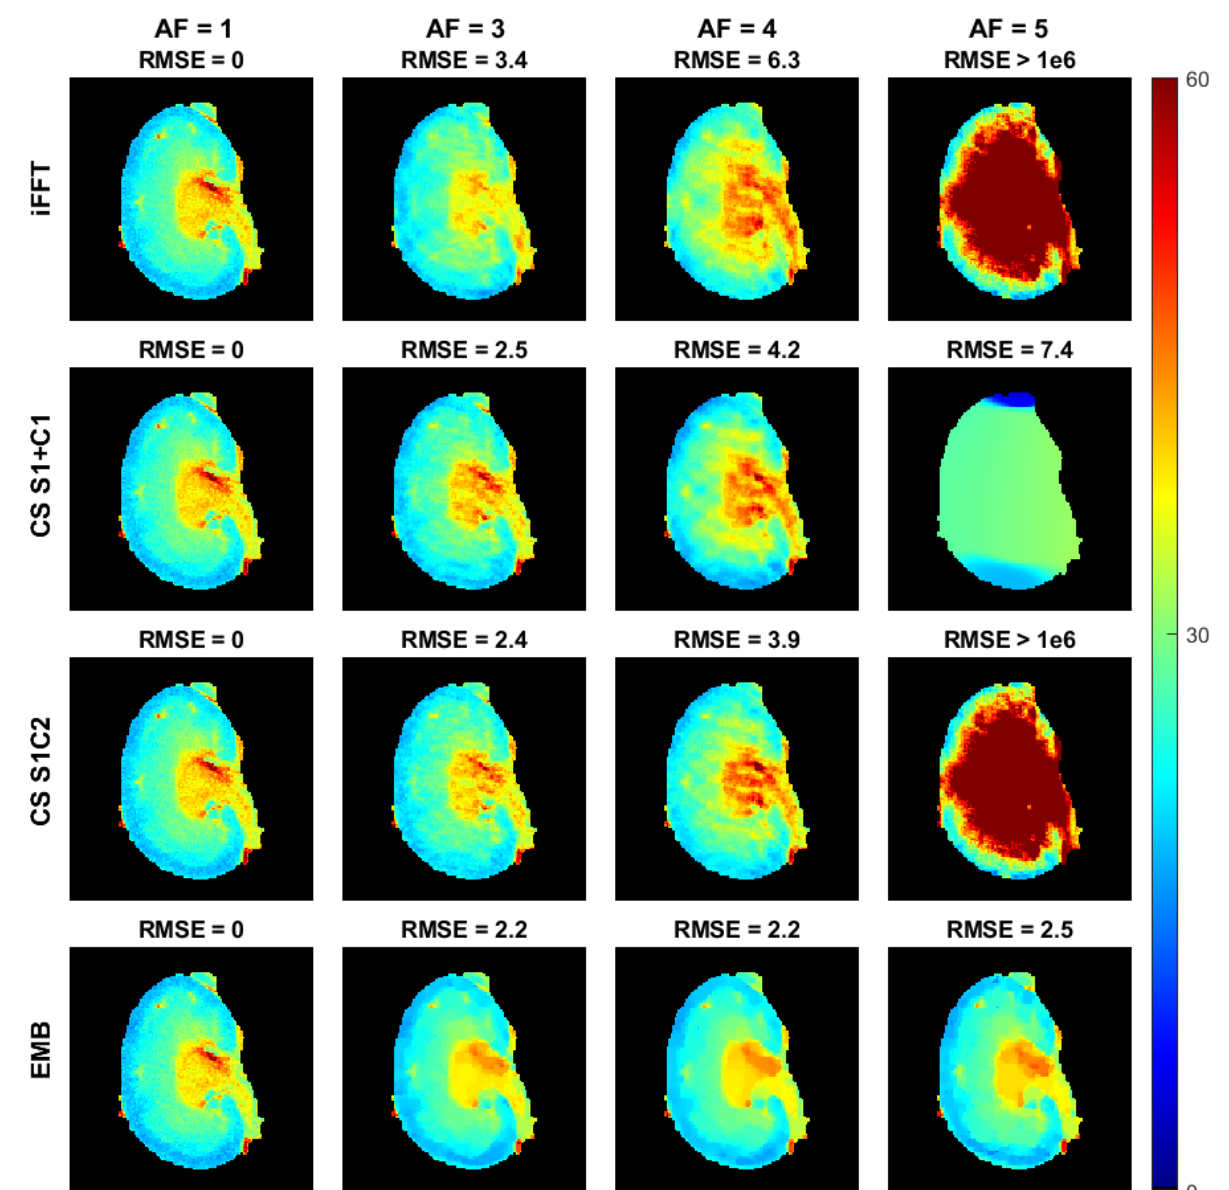
Figure 7. The T 1 ρ maps of the cartesian ex vivo mouse kidney data with the iFFT, CS S1+C1, CS S1C2, and embedded models, as well as the RMSEs as compared to the corresponding model reconstructions with full data. The top row contains the iFFT, the second row the CS S1+C1, and the third row the CS S1C2 model T 1 ρ parameter maps obtained from the monoexponential fit of Equation (15), and the bottom row contains the T 1 ρ maps obtained from the embedded model reconstructions. Columns 1–4 show the parameter maps corresponding to acceleration factors 1, 3, 4, and 5. Images are cropped to